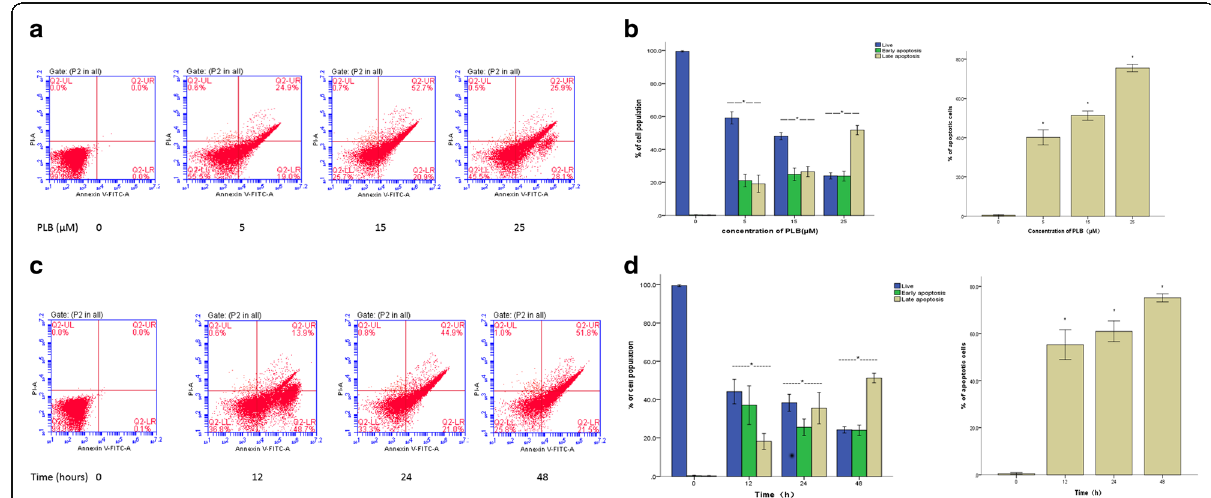
Fig. 2 Plumbagin enhanced apoptosis of ARPE cells. The apoptosis of cells was analyzed by Annexin V-FITC/PI assay. Data were represented the mean ± SD of three individual experiments. (* P < 0.05 by one-way ANOVA.). Notes: ( a ) Flow cytometric plots show cells in the live, early apoptosis, and late apoptosis stages when the cells were treated with PLB at 0, 5, 15 and 25 μ M for 24 h; ( b ) Bar graphs show the percentage of specific cell populations (live, early apoptosis, or late apoptosis) and total apoptosis cell population when the cells were treated with PLB at 0, 5, 15, and 25 μ M for 24 h; ( c ) Flow cytometric plots show cells in the live, early apoptosis, and late apoptosis stages when the cells were treated with 15 μ M PLB at 0, 12, 24,and 48 h; ( d ) Bar graphs show the percentage of specific cell populations (live, early apoptosis, or late apoptosis) and total apoptosis cell population when the cells were treated with 15 μ M PLB at 0, 12, 24, and 48